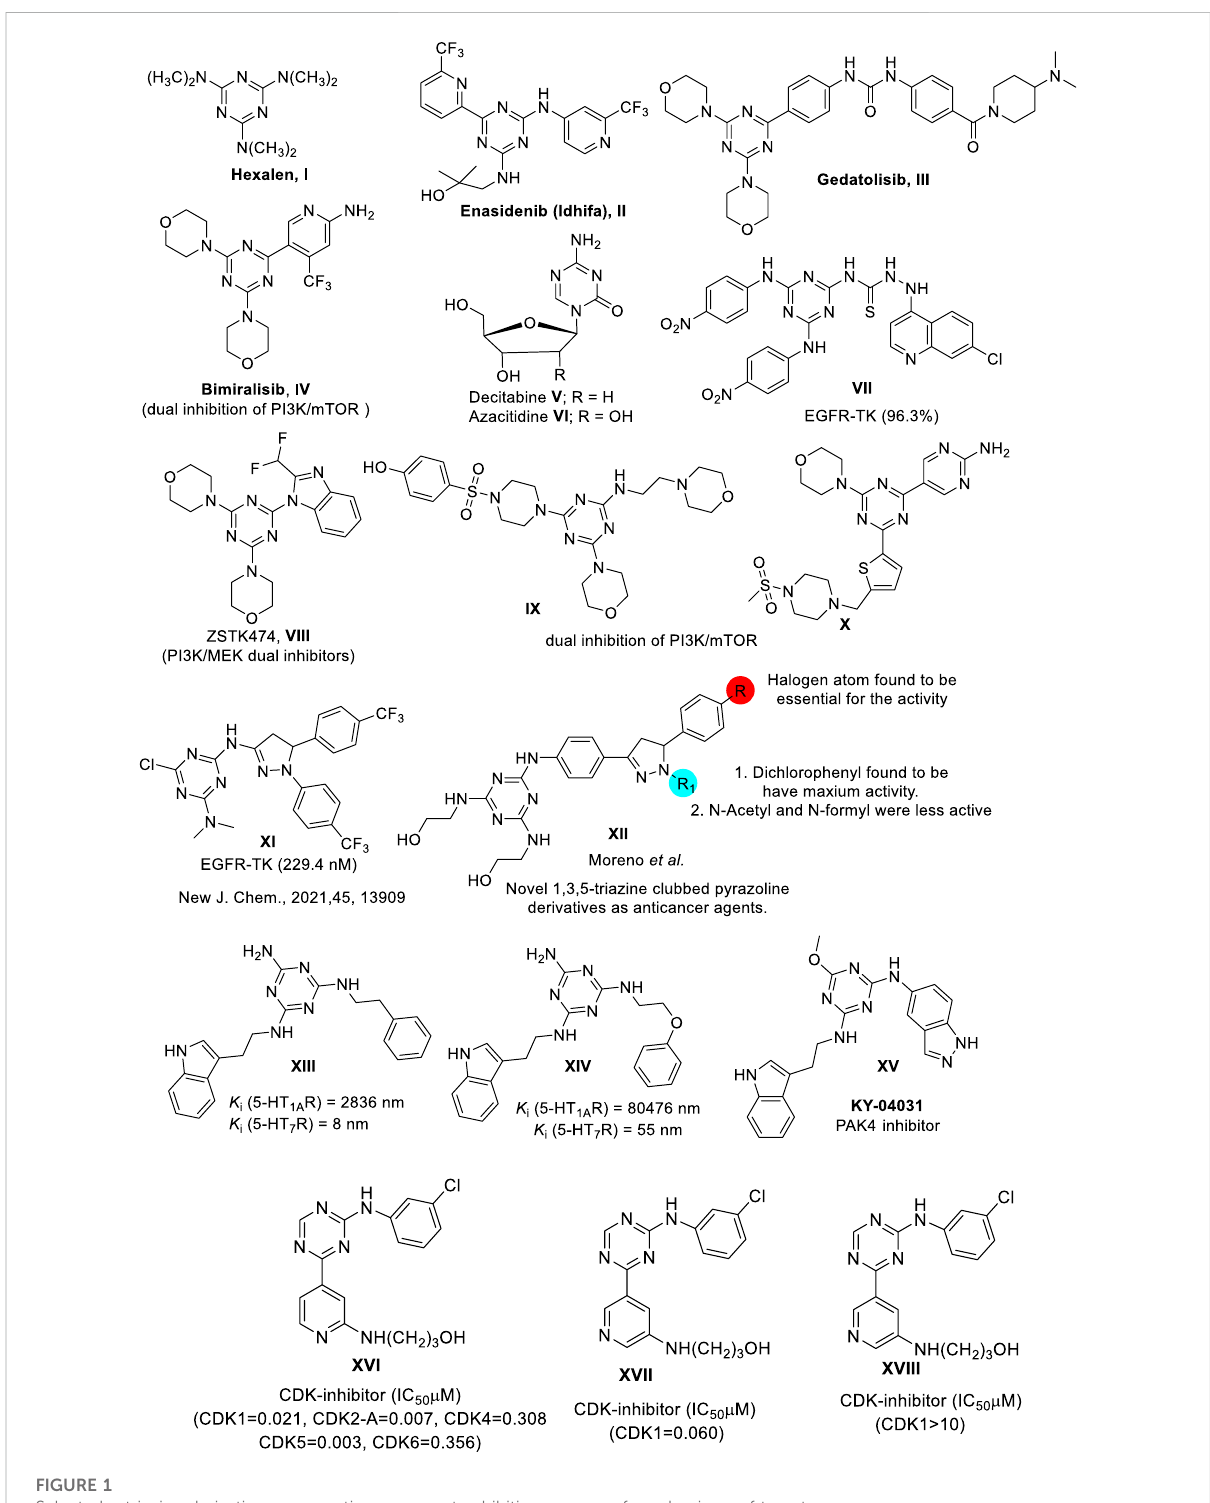
FIGURE 1 Selected s -triazine derivatives as an anticancer agent exhibiting a range of mechanisms of